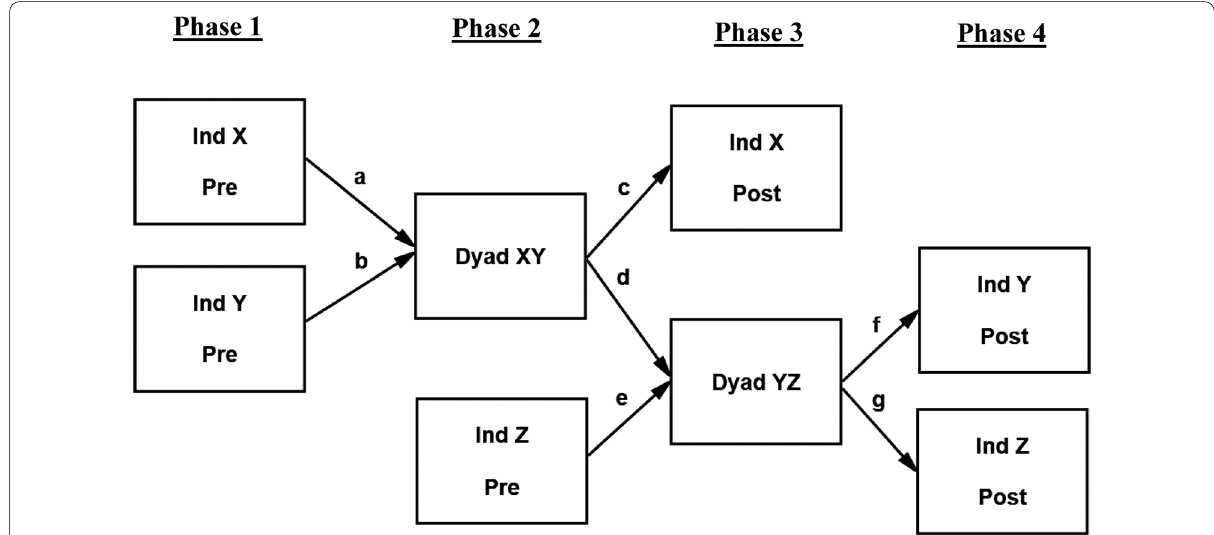
Fig. 1 A visualiazation of the full path model fit to the small-network chain sequence of the current study. Three network members (X, Y, Z) completed a temporal decision-making task individually (Ind) and in collaborative dyads. The network members completed the individual conditions both prior to collaboration (Pre) and after collaboration (Post). The path lettering is used to help identify the various direct and indirect social effects included in Tables 1 and 2. Paths included in the model but not shown in the figure for illustration purposes include: direct paths from network members’ pre-collaborative discount rates to their respective post-collaborative discount rates (e.g., Ind X Pre Ind X Post), covariances → between network members’ pre-collaborative discount rates (e.g., Ind X Pre Ind Y Pre), and covariances between post-collaborative residuals (e.g., ↔ Ind X Post Ind Y Post). The latter covariances were included to take into account the dependency of the group ↔